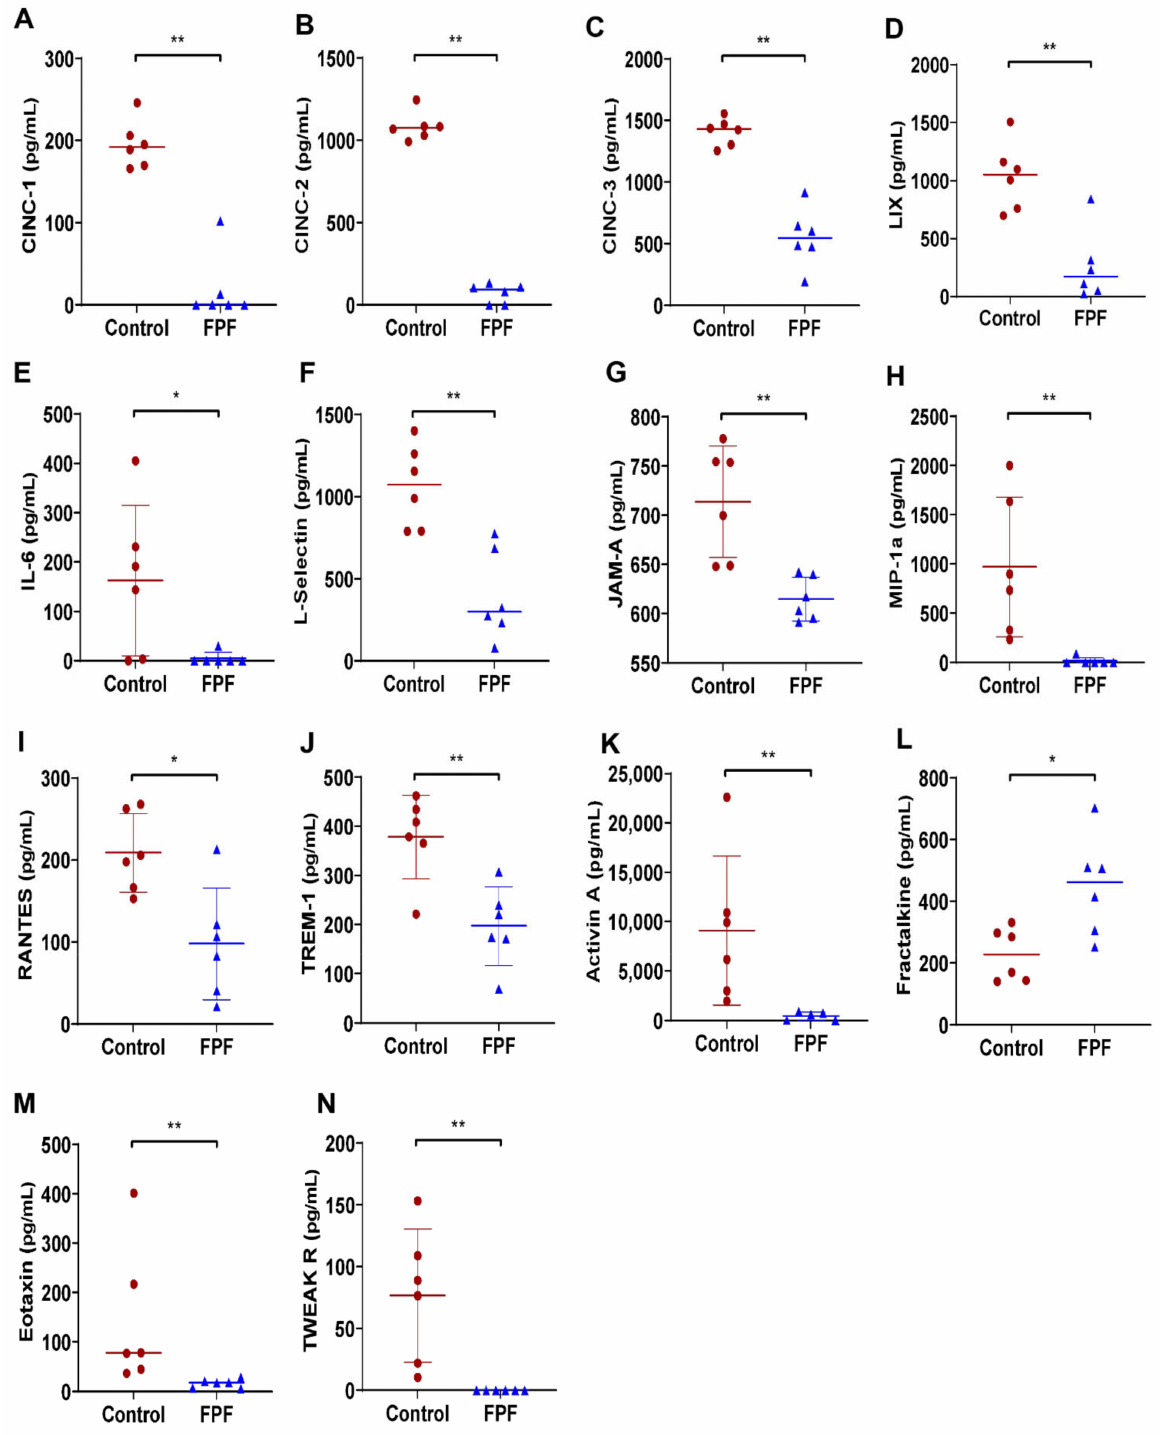
Figure 6. Anti-inflammatory effect of FPF on wound healing-associated cytokines. Levels of cytokines and chemokines in the wound tissue collected after wound closure for ( A ) CINC-1, ( B ) CINC-2, ( C ) CINC-3, ( D ) LIX, ( E ) IL-6, ( F ) L- selectin, ( G ) JAMA-A, ( H ) MIP-1 α , ( I ) RANTES, ( J ) TREM-1, ( K ) activin A, ( L ) fractalkine, ( M ) eotaxin, and (N) TWEAK R. N = 6 rats/group. * p < 0.05, ** p <